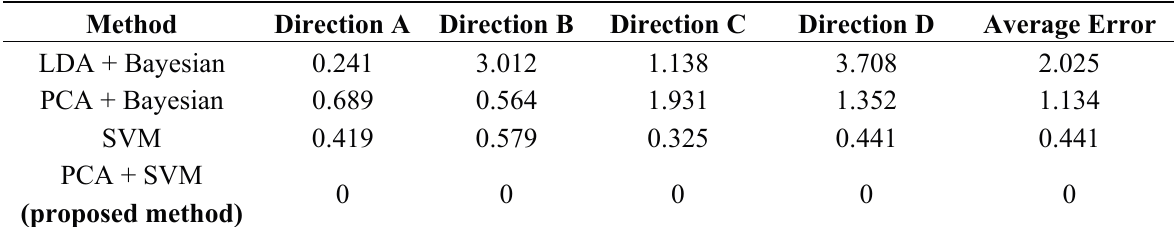
Figure 7. ROC curve from the pre-classification stage using two testing sub-databases (In each figure, PCA+SVM is the proposed method): ( a ) the average classification results for the obverse side (Direction A or B) and the reverse side (Direction C or D); ( b ) the average classification results for Direction A and Direction B; and ( c ) the average classification results for Direction C and Direction D. Table 5. Average error rates during pre-classification using two testing sub-databases (unit: